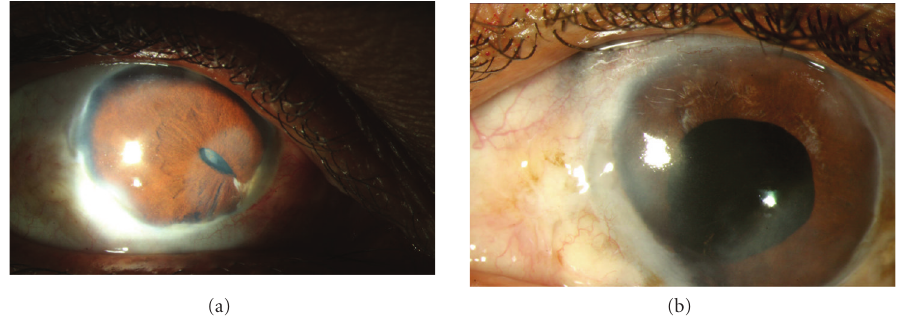
Figure 2: A 48-year-old lady was diagnosed as bilateral sclera-keratouveitis, with complicated cataract. She was investigated extensively and had a positive Mantoux test, for which she received anti-tubercular therapy. She underwent cataract surgery in the left eye with a preoperative visual acuity of counting fingers. Postoperatively, her visual acuity improved to 20/125, limited by the presence of a central corneal scar. (a) Shows the right eye showing evidence of healed scleritis, corectopia, and a complicated cataract. (b) Shows the left eye two months